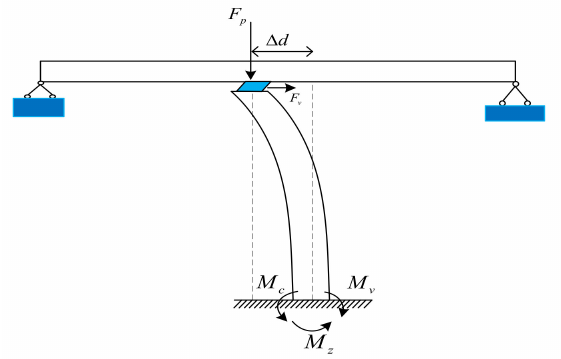
Figure 7. Schematic diagram of the bending moment at the bottom of the pier.